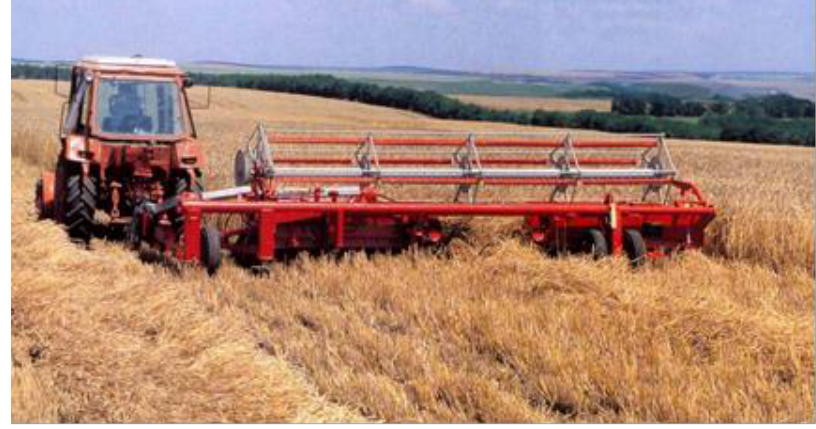
Figure 1. The aggregating wheeled tractor and the trailed asymmetric.